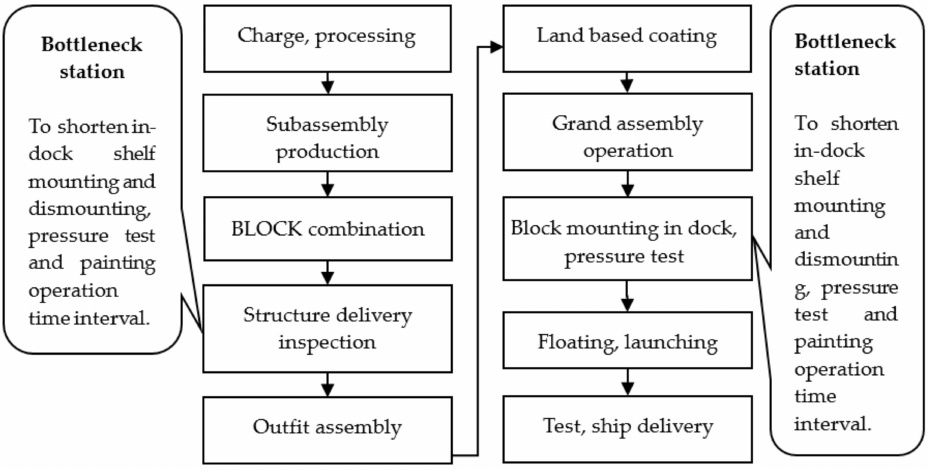
Figure 3. Commercial ship production flow of the sample